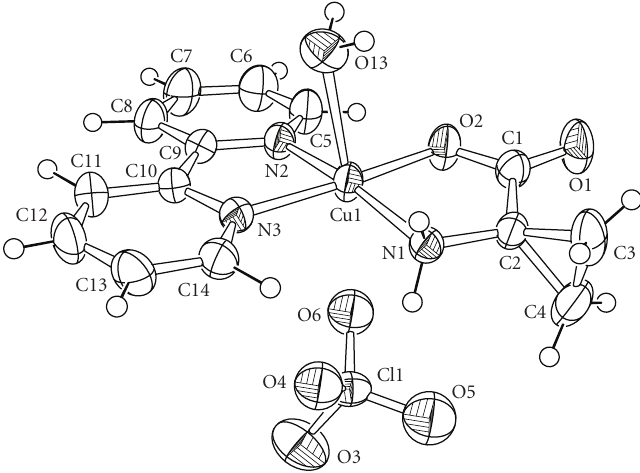
Figure 1: ORTEP drawing of 1